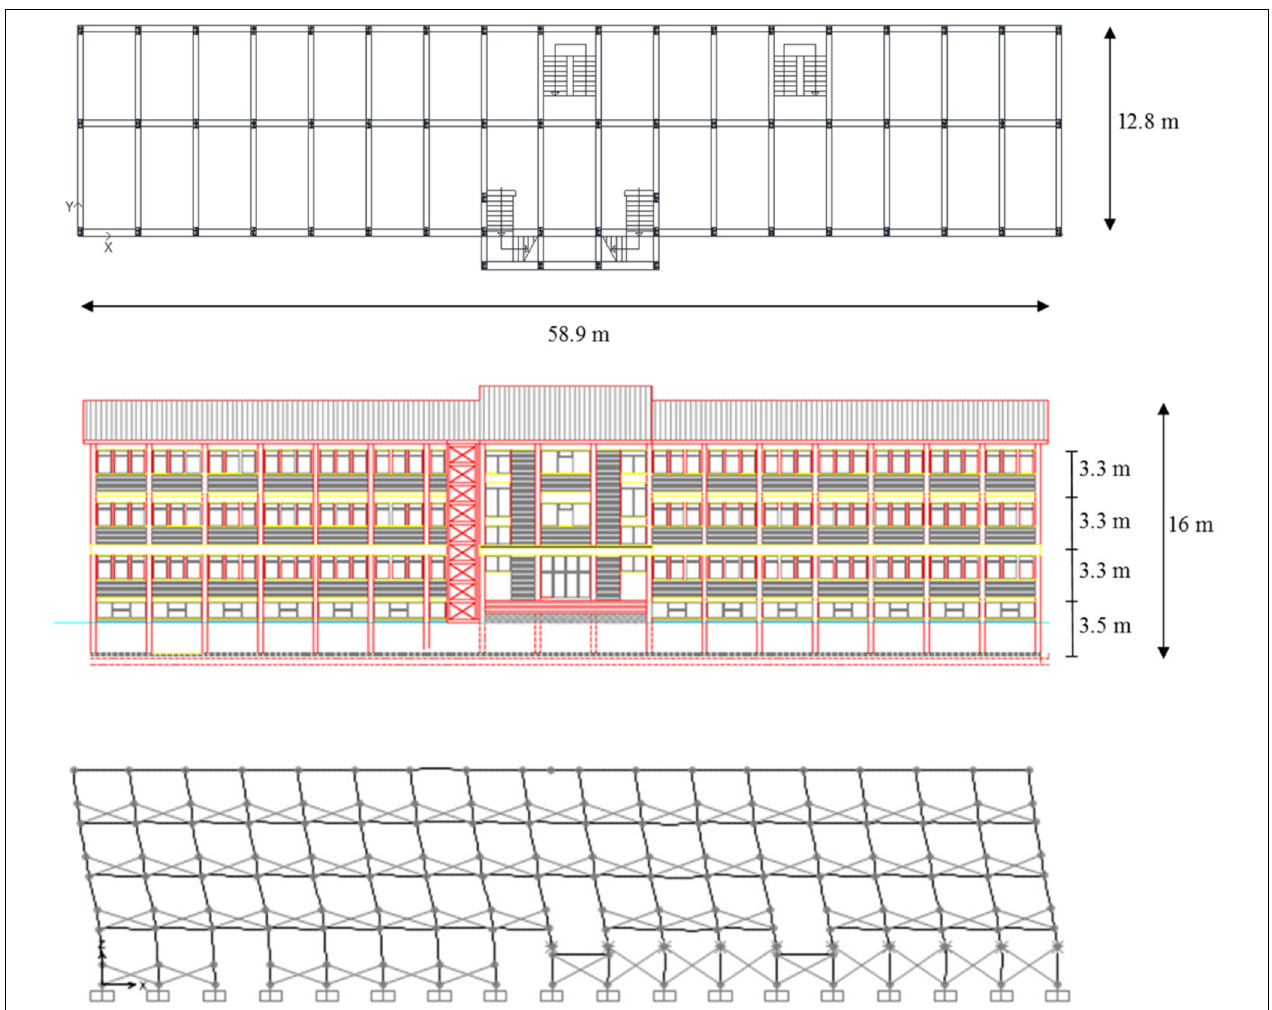
FIGURE 10 | Plan and elevation views of the case study and first modal shape in x–z